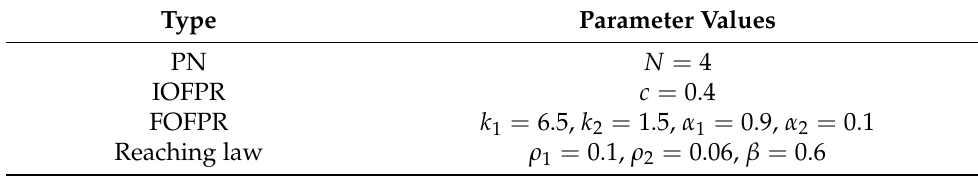
Table 4. Parameters of the guidance law.